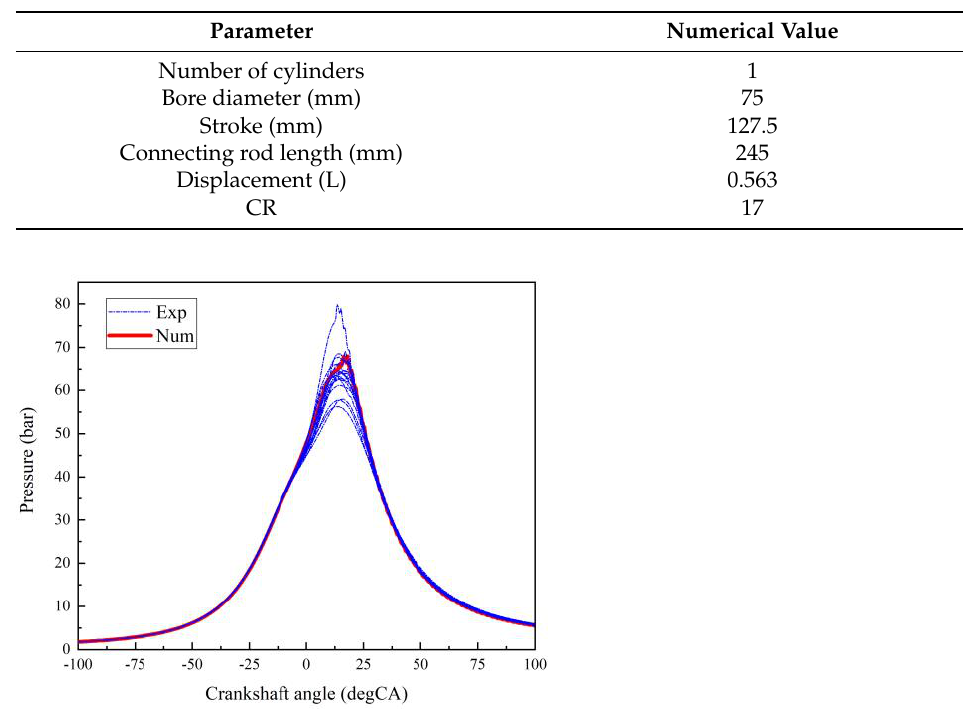
Table 7. Basic parameters of the knock validation engine.